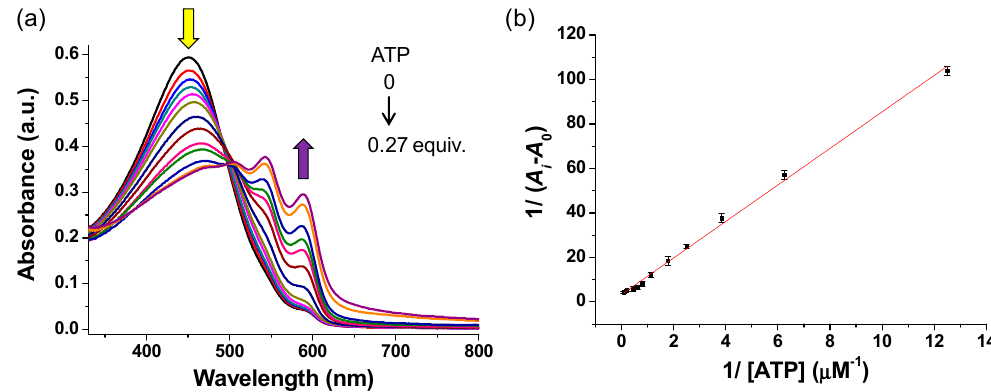
Figure 3. ( a ) UV-Vis absorption spectra of L (50 μ M) with the addition of ATP with concentrations ranging from 0 to 13.6 μ M in tris -HCl buffer solution (10 mM, pH = 7.4); ( b ) Absorbance at 540 nm of L as a function of ATP concentration. A 0 is the initial absorbance of L at 540 nm, and A i is the recorded absorbance of L in the presence of ATP with different concentrations. Error bars represent the standard deviations of three trials.